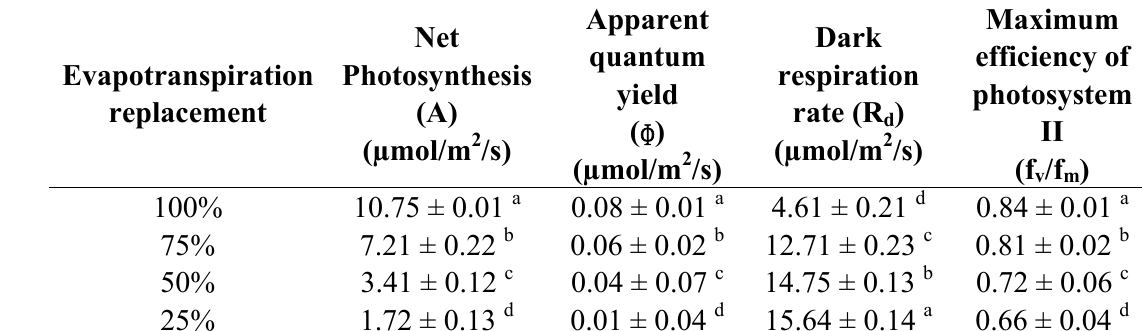
Table 3. Net photosynthesis, Apparent quantum yield, dark respiration and maximum efficiency of photosystem ii (f evapotranspiration replacement